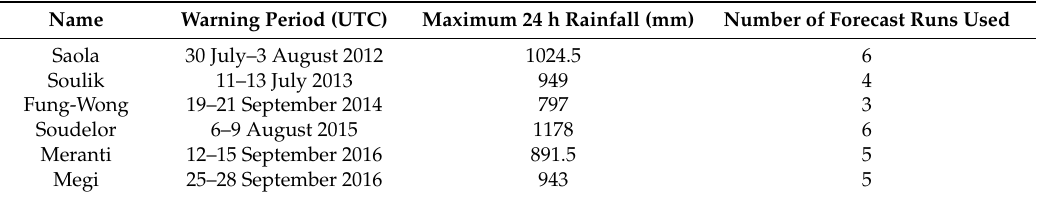
Table 1. List of typhoons used in this